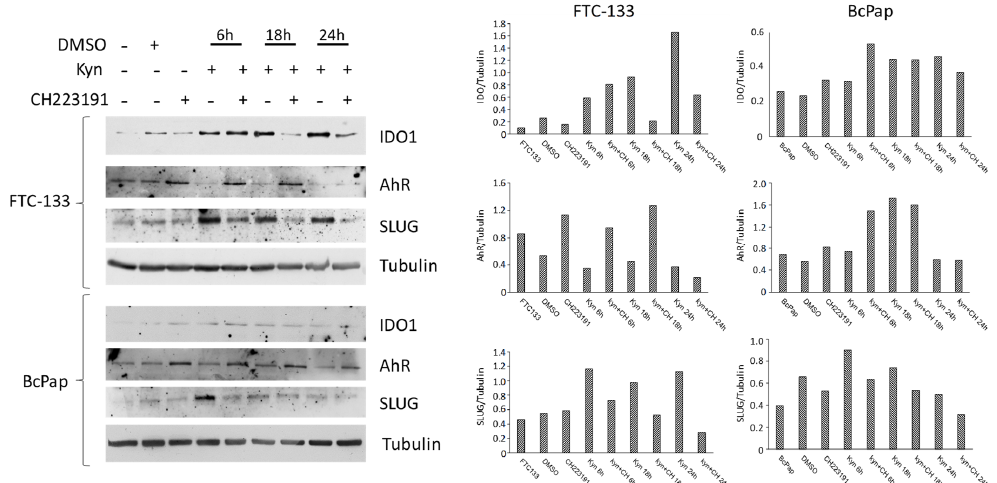
Figure 7. Effects of kynurenine on IDO1, AhR and SLUG protein levels. FTC-133 and BcPap cells were incubated for the indicated times with kynurenine (100 µM) in the presence or absence of the AhR inhibitor CH223191 (10 µM) and harvested for protein extraction. Expression of IDO1, AhR, SLUG and tubulin were assayed by immunoblot. All the experiments were repeated twice, and the more representative results are depicted. The bands of the shown experiment were analyzed by densitometry and normalized with tubulin. DMSO: Dimethyl sulfoxide treated cells; Kyn: kynurenine treated cells; CH: CH223191 treated cells.